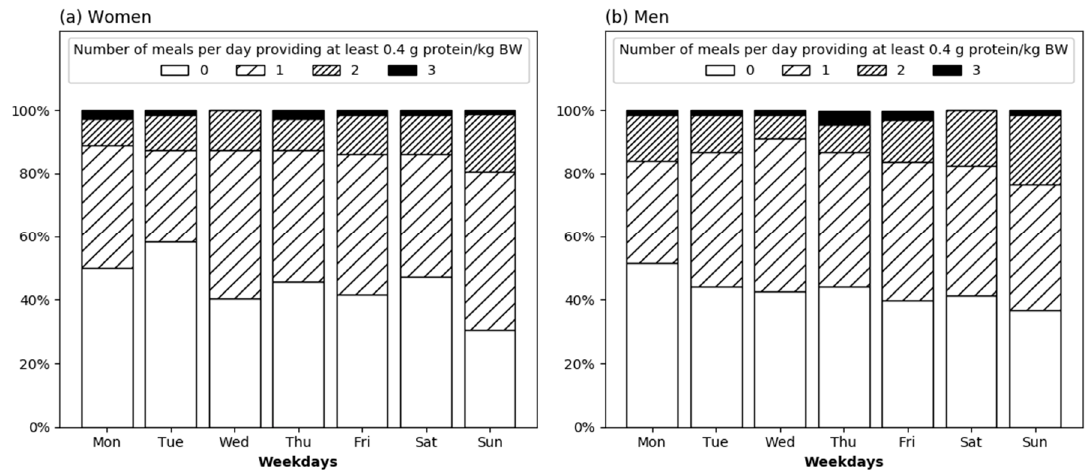
Figure 4. Proportion of healthy community-dwelling older women ( n = 72) ( a ) and men ( n = 68) ( b ) consuming 0, 1, 2 or 3 daily meals providing at least 0.4 g protein/kg body weight (BW) by weekday.